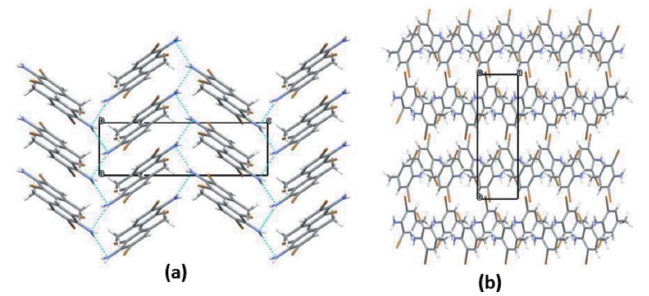
Figure 2 Views along the ( a ) b and ( b ) c axes of the crystal packing of the title compound with hydrogen bonds shown as dotted lines.